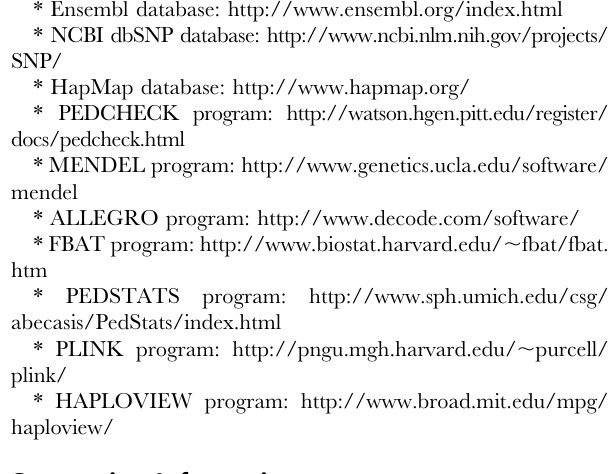
Table S1 Complete results of the family-based association linkage disequilibrium mapping study (Illumina BeadChip geno- typing - 136 families).